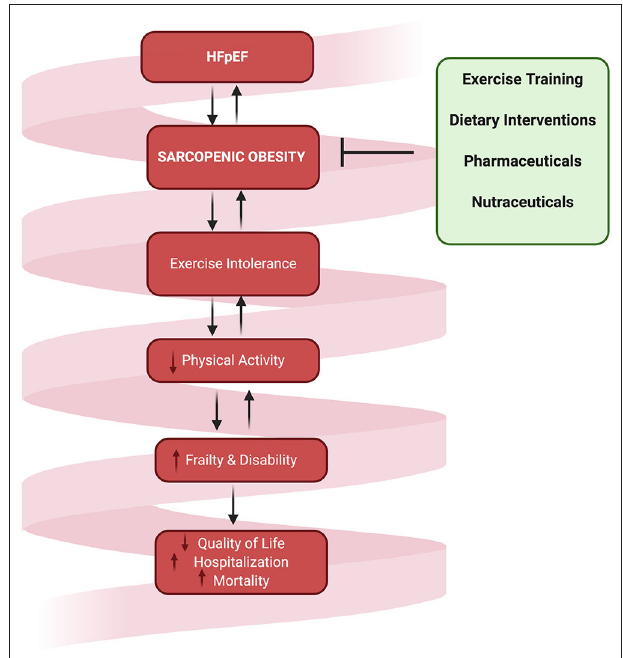
FIGURE 1 | The multifaced pathophysiological contributors to sarcopenia in HFpEF. These factors all contribute to physical inactivity which results in reduced energy expenditure and disuse atrophy, initiating a deleterious vicious cycle between physical inactivity, co-morbidity, and augmented SO.